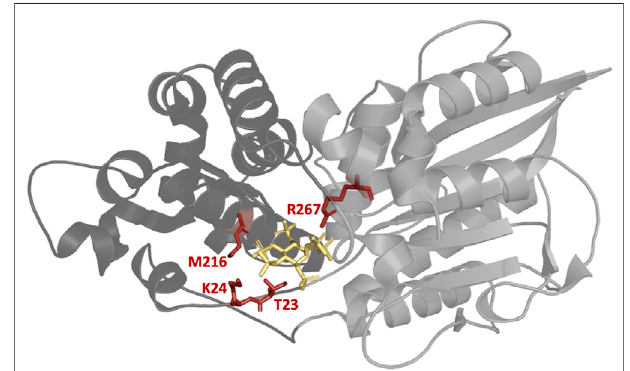
FIGURE 6 | Structure of the E. coli phytase with bound InsP 6 (yellow). The four highlighted residues T23, K24, M216, and R267 are all located in the binding pocket and have proven to be the most suitable sites for substitution to increase hydrolytic activity against InsP 4 . Smaller α -domain and the more conserved α /ß domain of Ec phy are represented in dark and light gray, respectively. PDB accession code 1DKQ. Figure created with Chimera (Pettersen et al.,